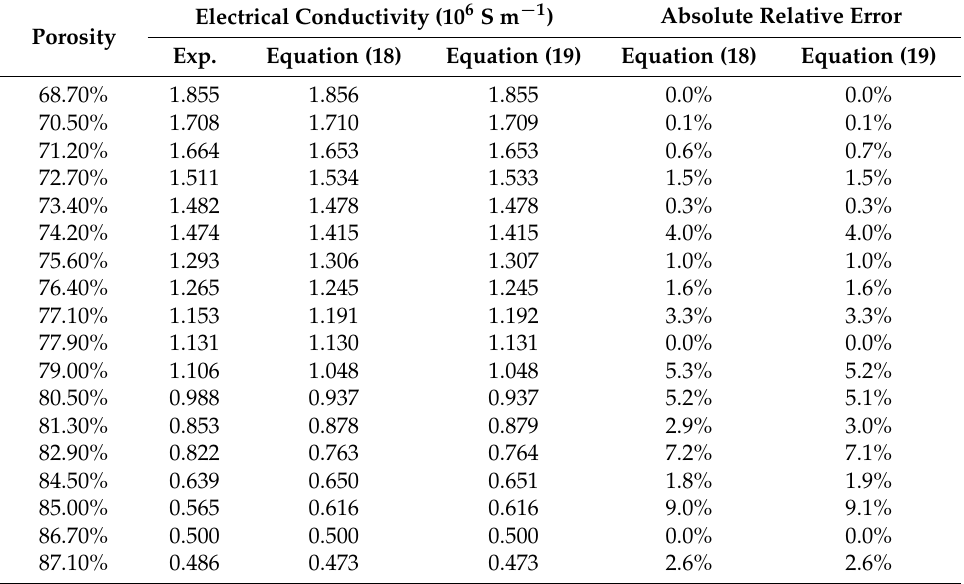
Table 4. Experimental data from Feng et al. [30] and calculated values of electrical conductivity of aluminum foam using the new proposed